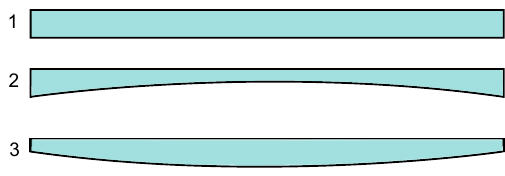
Figure 12. Three different leaf spring shapes, shown in the x-y-plane. Leaf Spring 1 is a uniform beam, and Leaf Springs 2 and 3 are beams with a negative and positive parabola cutout, respectively.